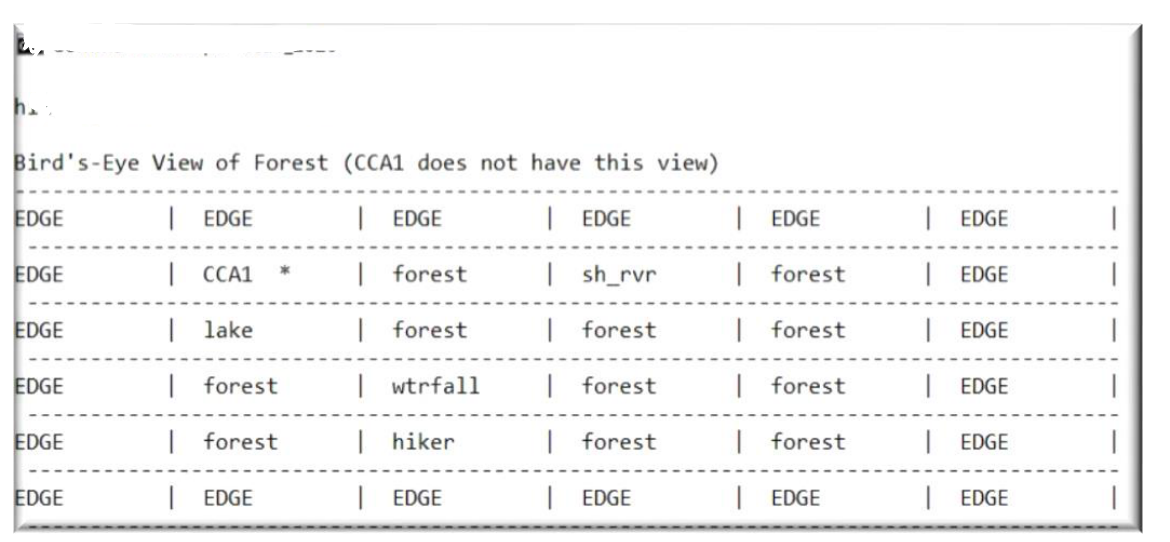
Figure 4. Overview of the Starting Positions of the lost hiker and the CCA1 architecture/agent in a simulated gridworld. The CCA1 does not have this data about the world but has to create its own internal maps.